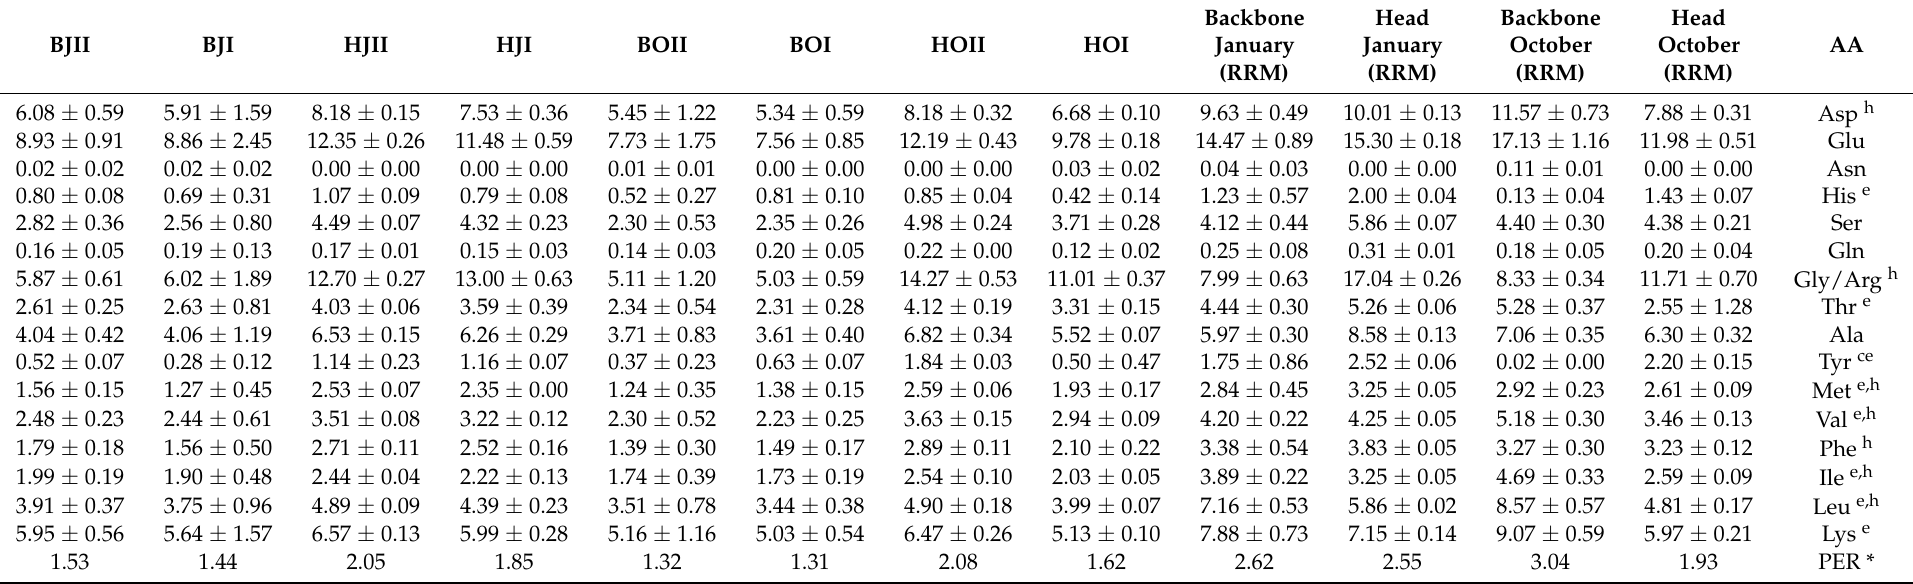
Table 1. Total amino acid composition (g/100 g protein) in RRM and SPH obtained from enzymatic hydrolysis of heads (H) and backbones (B) in two bioreactors (I, II) from saithe caught in October 2019 (HOI, HOII, BOI, BOII) and January 2020 (HJI, HJII, BJI, BJII) (x ± SEM, n = 3). Essential [35] and hydrophobic [36] amino acids are indicated by e and h, respectively. * Calculated